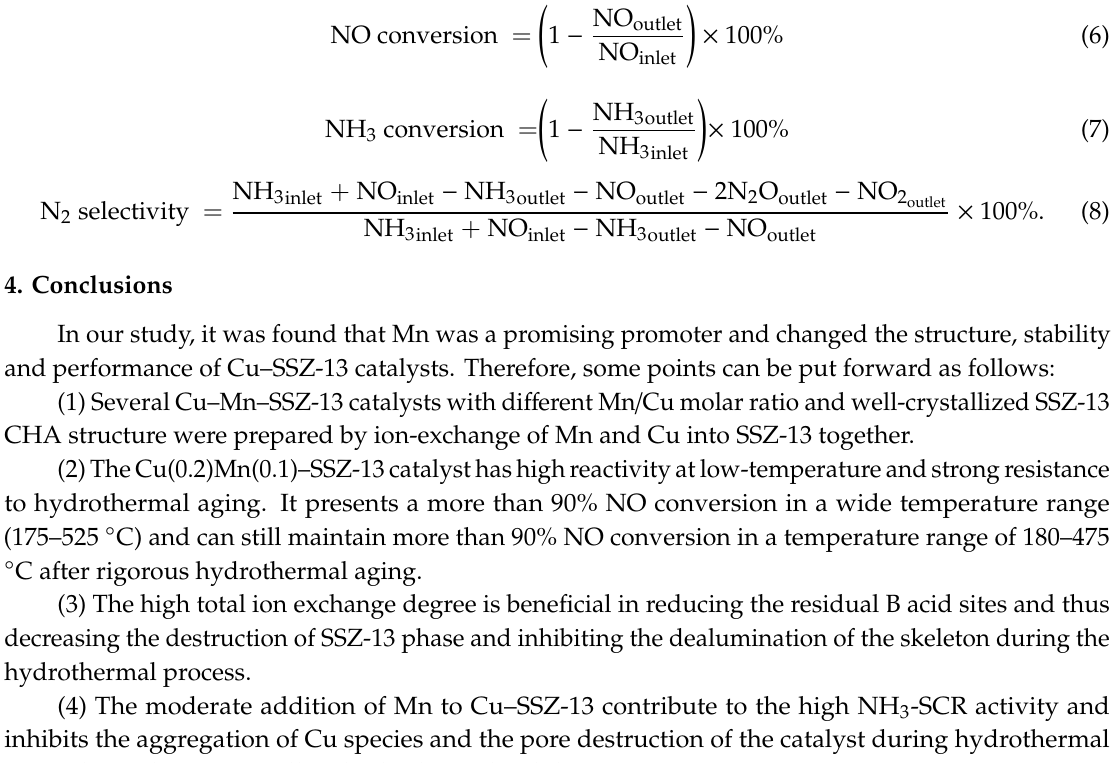
Figure S1: XRD pattern of the synthetic SSZ-13 powder, Figure S2: SEM images of the synthetic SSZ-13 powder, Figure S3: XRD patterns of di ff erent Cu–Mn–SSZ-13 catalysts, Figure S4: Temperature